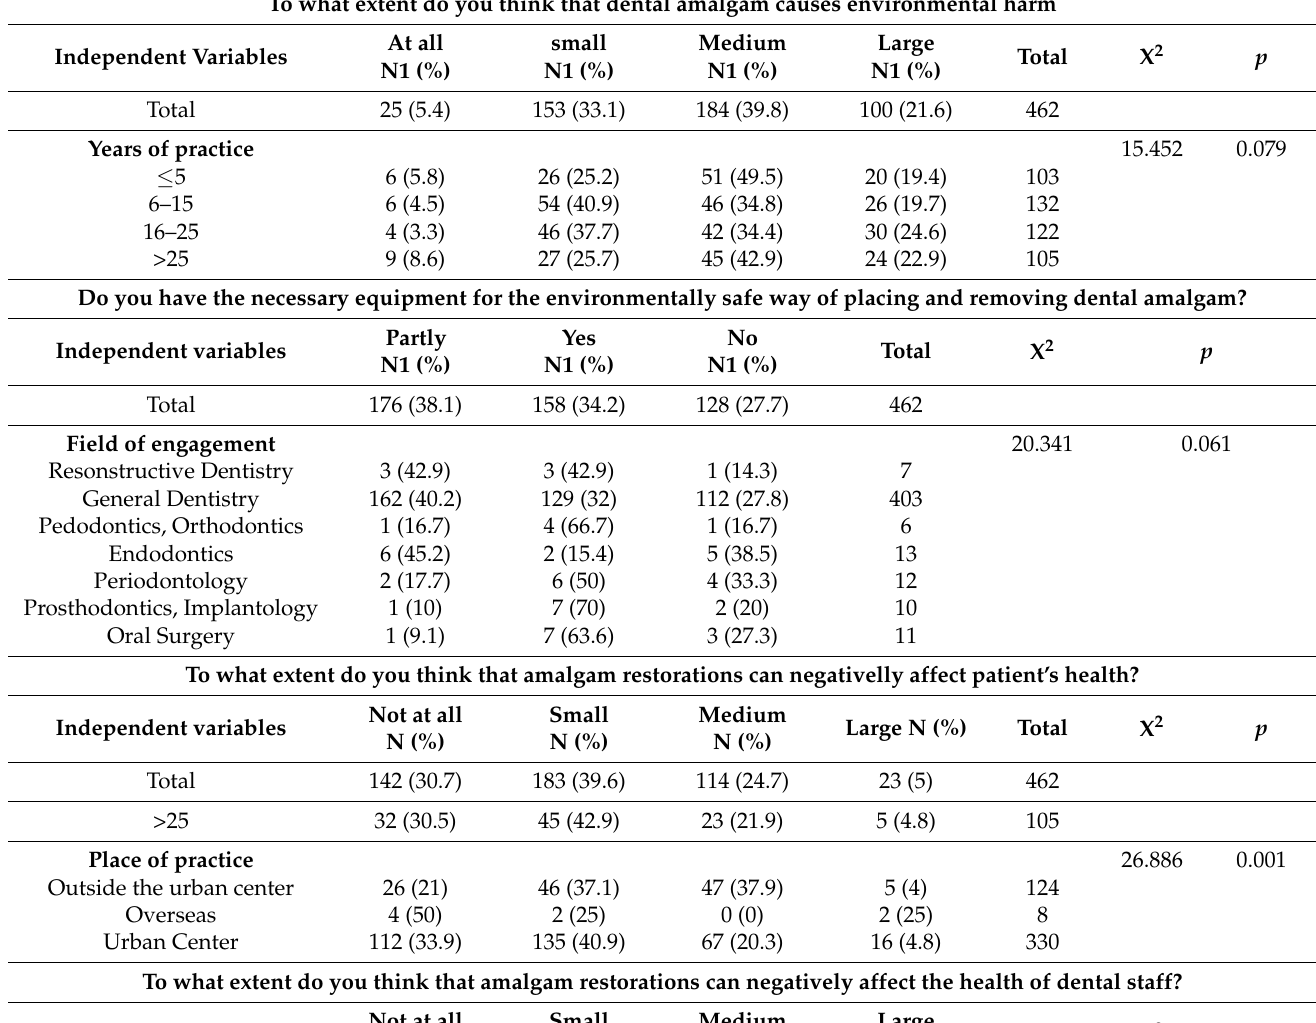
Table 1. Significant values for